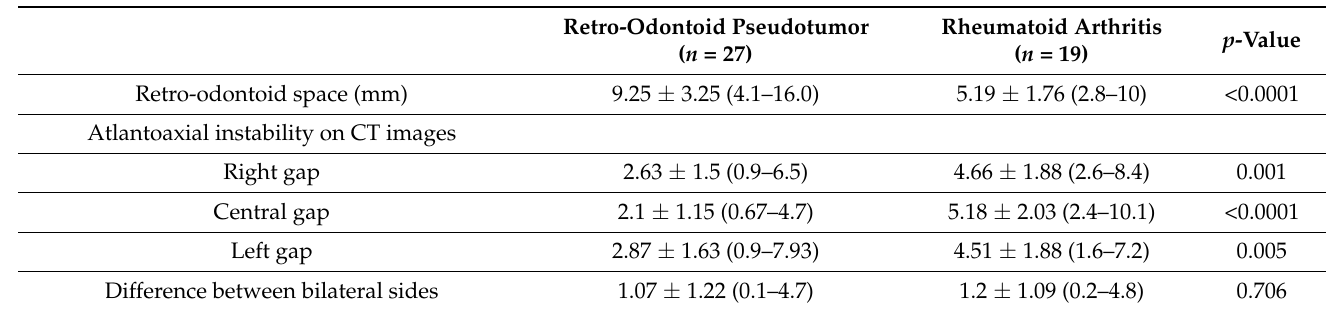
Table 2. Cont. Retro-Odontoid